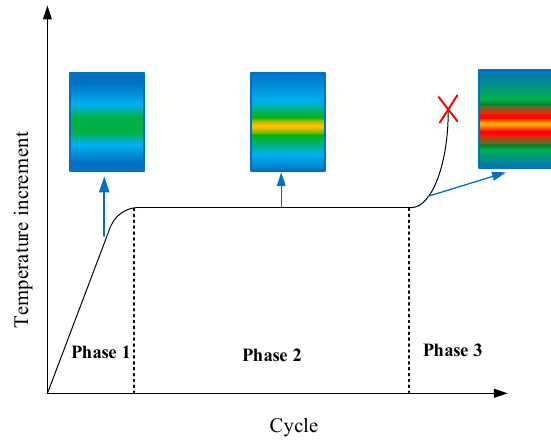
Figure 2. Three phases of the temperature increase in the fatigue test.